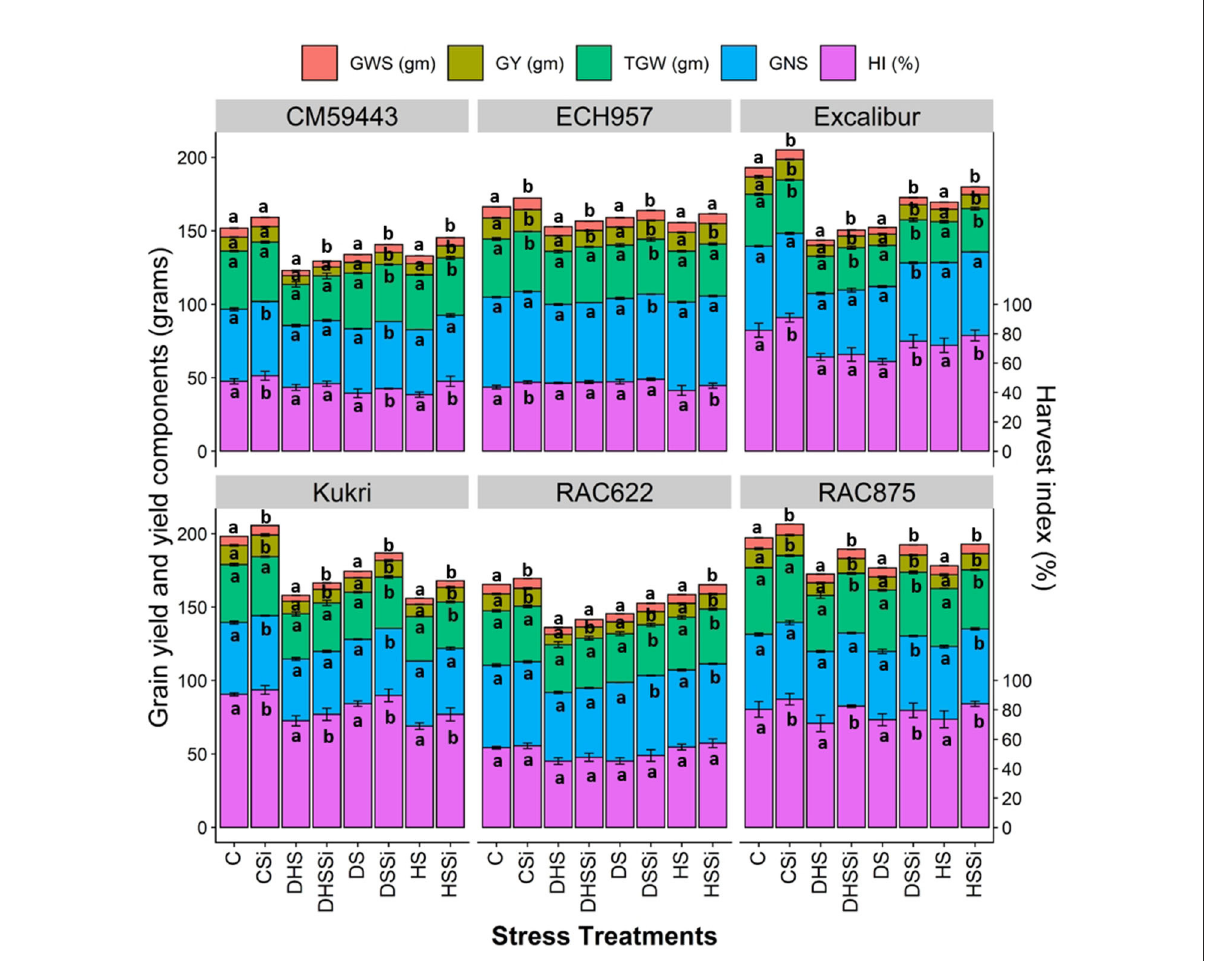
FIGURE5 Effect of silicon on the mean values of grain yield (GY) and yield components of six contrasting wheat cultivars under DS, HS, and DHS in a controlled glasshouse condition. Each value represents the mean ± SE, represented with error bars. Different letters indicate significant differences within the cultivars at p < 0.05. Abbreviations are grain weight per spike (GWS, grams; presented as GWS × 10 ∧ 0.5 ), grain yield per pot (GY, grams), 1,000 grains weight (TGW, grams), number of grains per spike (GNS), and harvest index (HI,